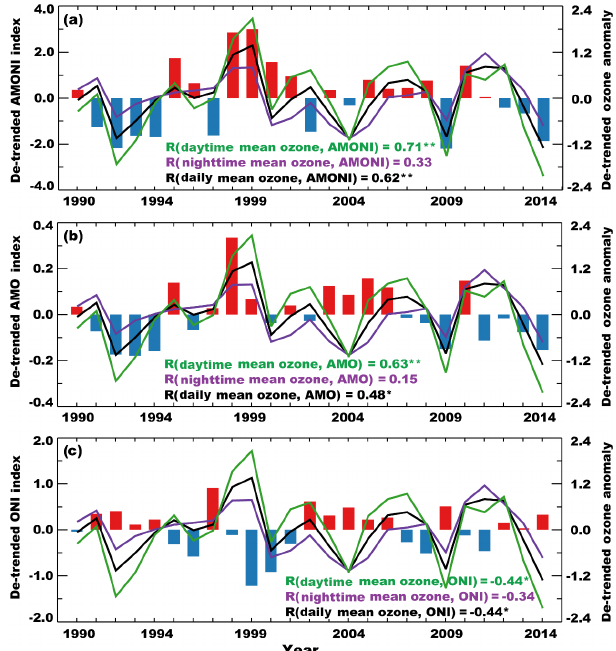
Figure 6. Detrended anomaly time series of climate indices and ob- served US mean ozone. The anomalies of annual mean daily mean ozone (black lines), daytime mean ozone (green lines), and night- time mean ozone (purple lines) are plotted with the annual AMONI index (a) , with the annual AMO index (b) , and with the annual ONI index (c) . Red and blue bars indicate positive and negative anoma- lies of climate indices, respectively. Also shown are correlations be- tween ozone and individual indices ( ∗∗ for P value<0.01 and ∗ for P value<0.05 after a one-sided t